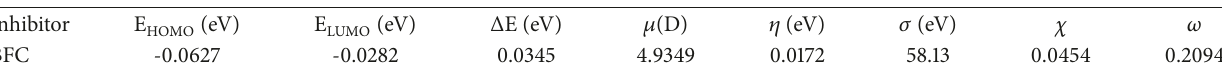
Table 8: Quantum chemical parameters for